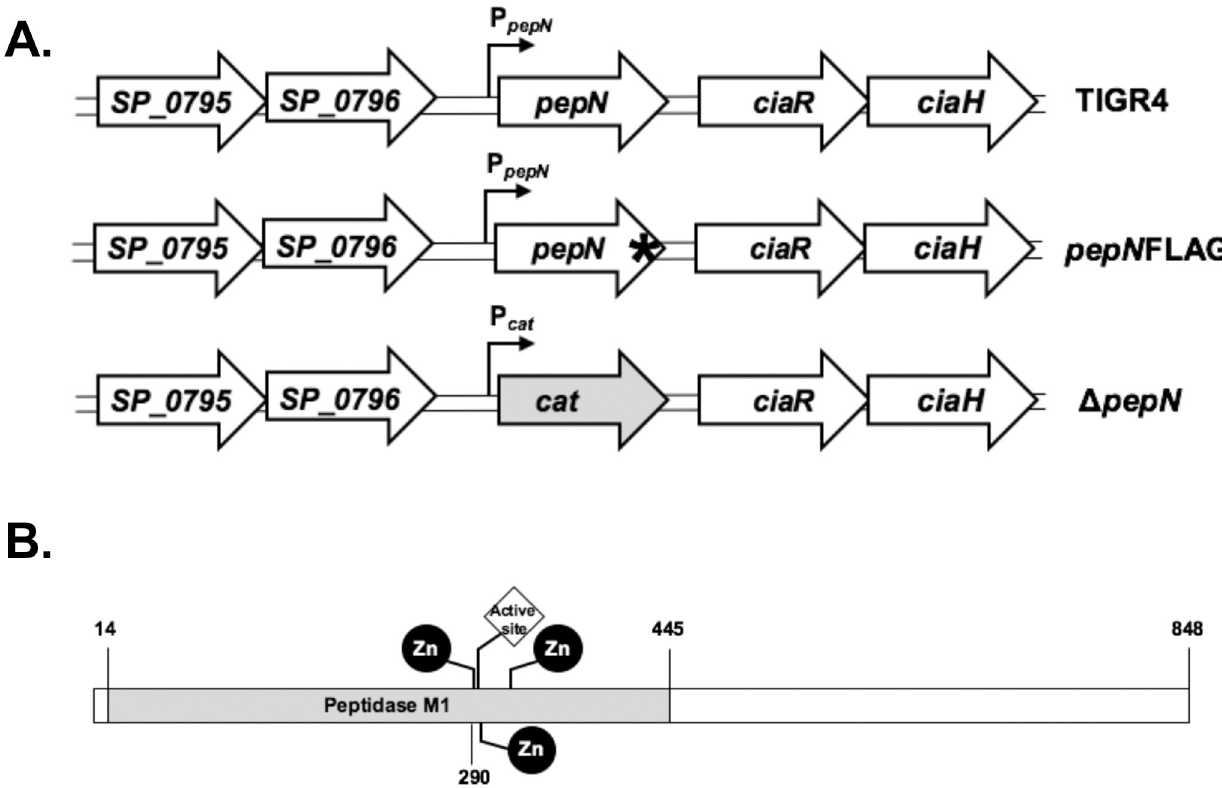
Fig 1. Schematic of DNA constructs used to generate Spn mutant strains and the domain structure of the PepN protein. ( A) The depicted DNA constructs were used to create mutant strains of S . pneumoniae via allelic exchange. In the Δ pepN strain, the pepN ORF was replaced by a Cm resistance cassette. In the pepN FLAG mutant a 1X FLAG tag (denoted by � ) was added to the C terminus of the PepN protein, immediately upstream of the stop codon. (B) The domain structure of PepN was determined using BLASTP to be comprised of a peptidase M1 domain containing an active site coordinated by three zinc binding sites (residues 292, 296 and